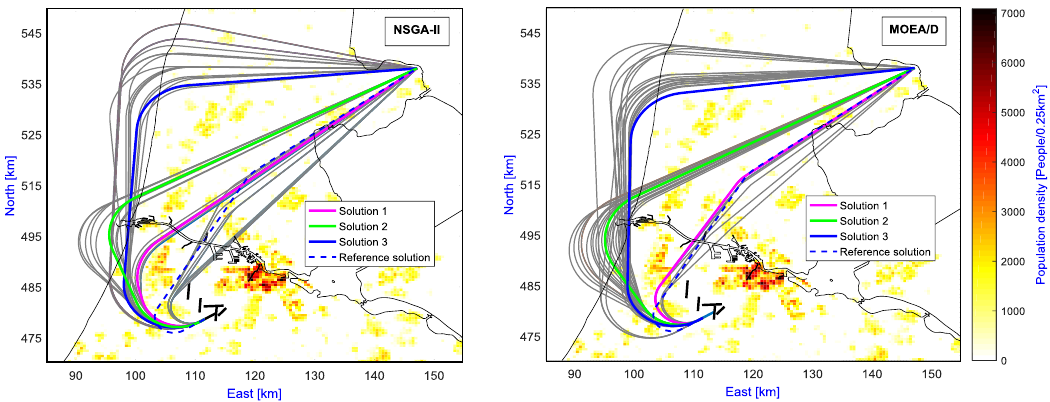
Figure 4. Optimal ground tracks obtained by NSGA-II (left) and MOEA/D (right).